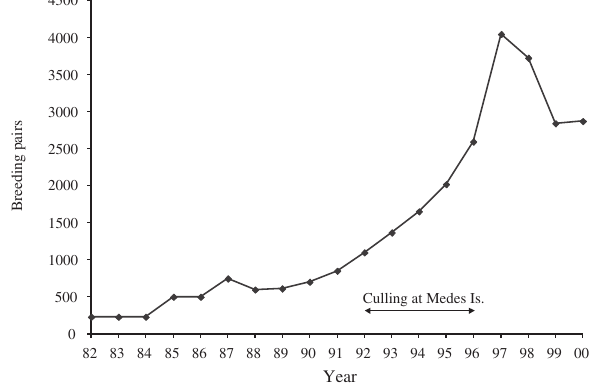
F IG . 6. – Number of yellow-legged gull pairs breeding at the Ebro Delta (western Mediterranean) during the last two decades. The years of culling affecting the colony of the Medes Islands are also